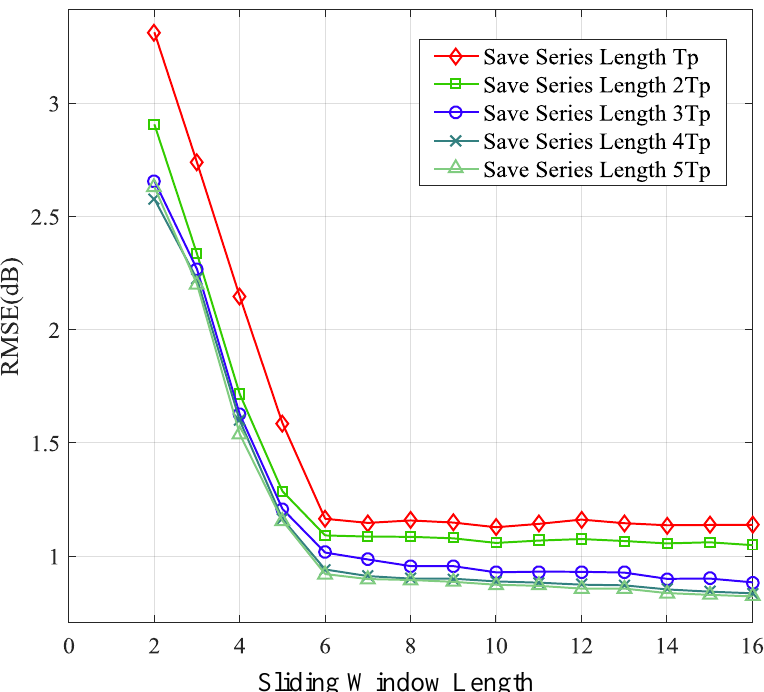
Figure 15. RMSE of 5-step ahead prediction with different length of sliding window and stored